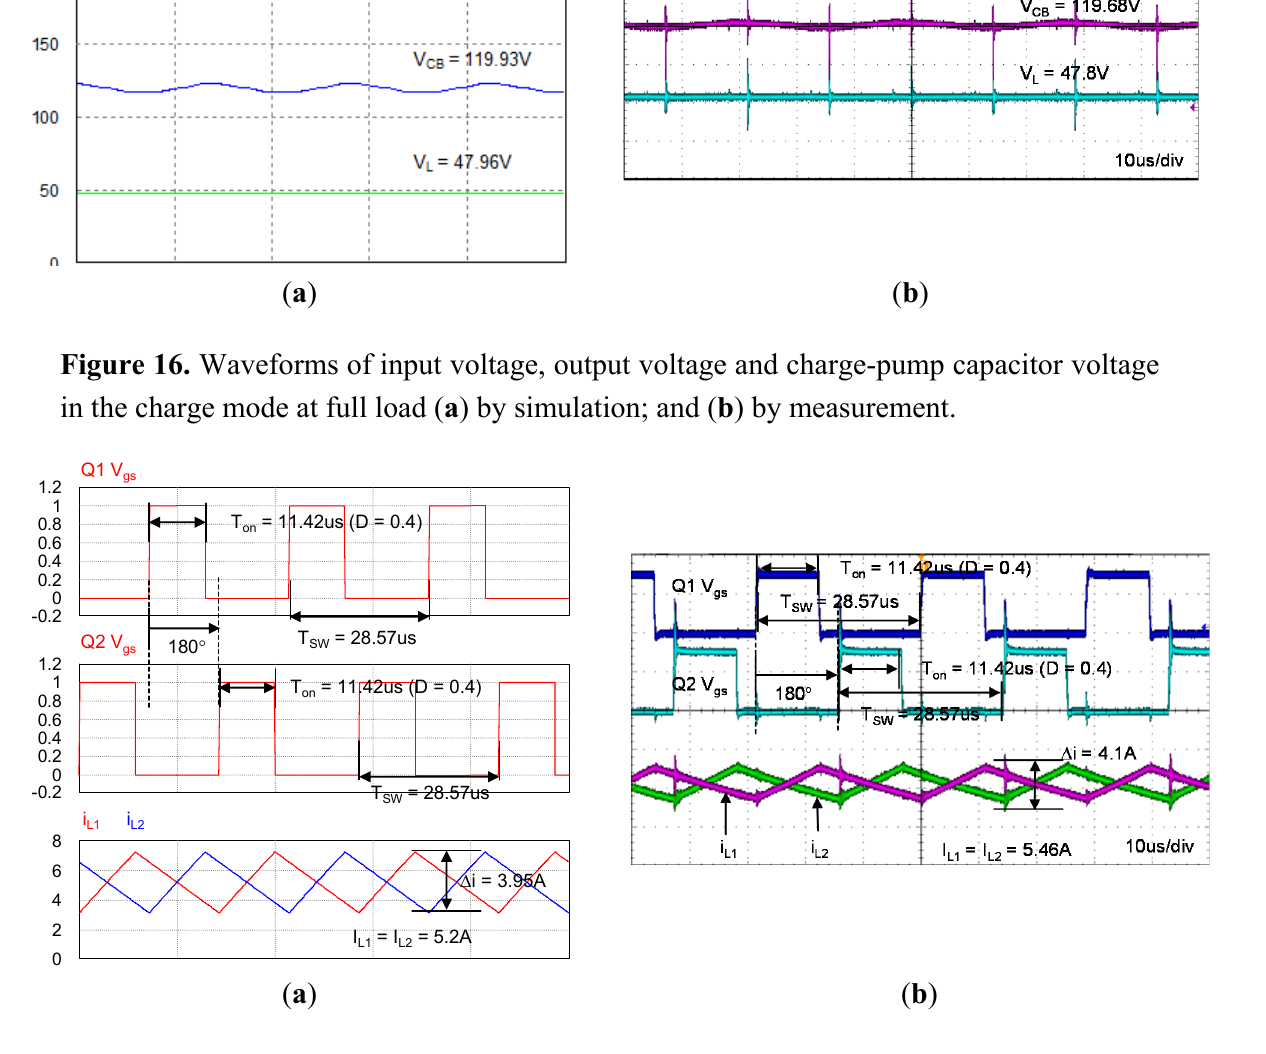
Figure 17. Waveforms of gate signals of high-side switches Q 1 ~ Q 2 , and two-phase inductor currents i L 1 ~ i L 2 in the charge mode at full load ( a ) by simulation; and ( b ) by